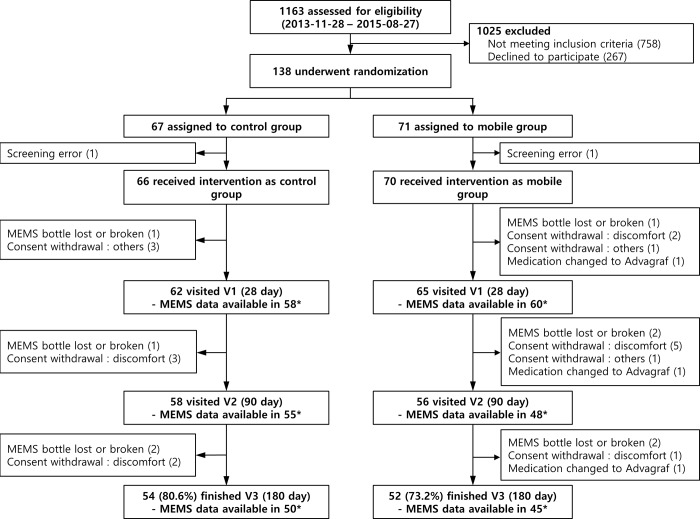
CONSORT diagram.